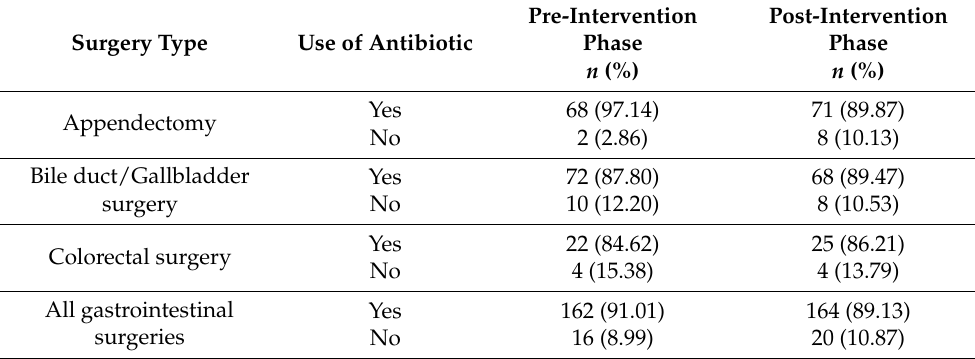
Table 3. Frequency of antibiotic use for gastrointestinal surgeries during the pre- and post-intervention